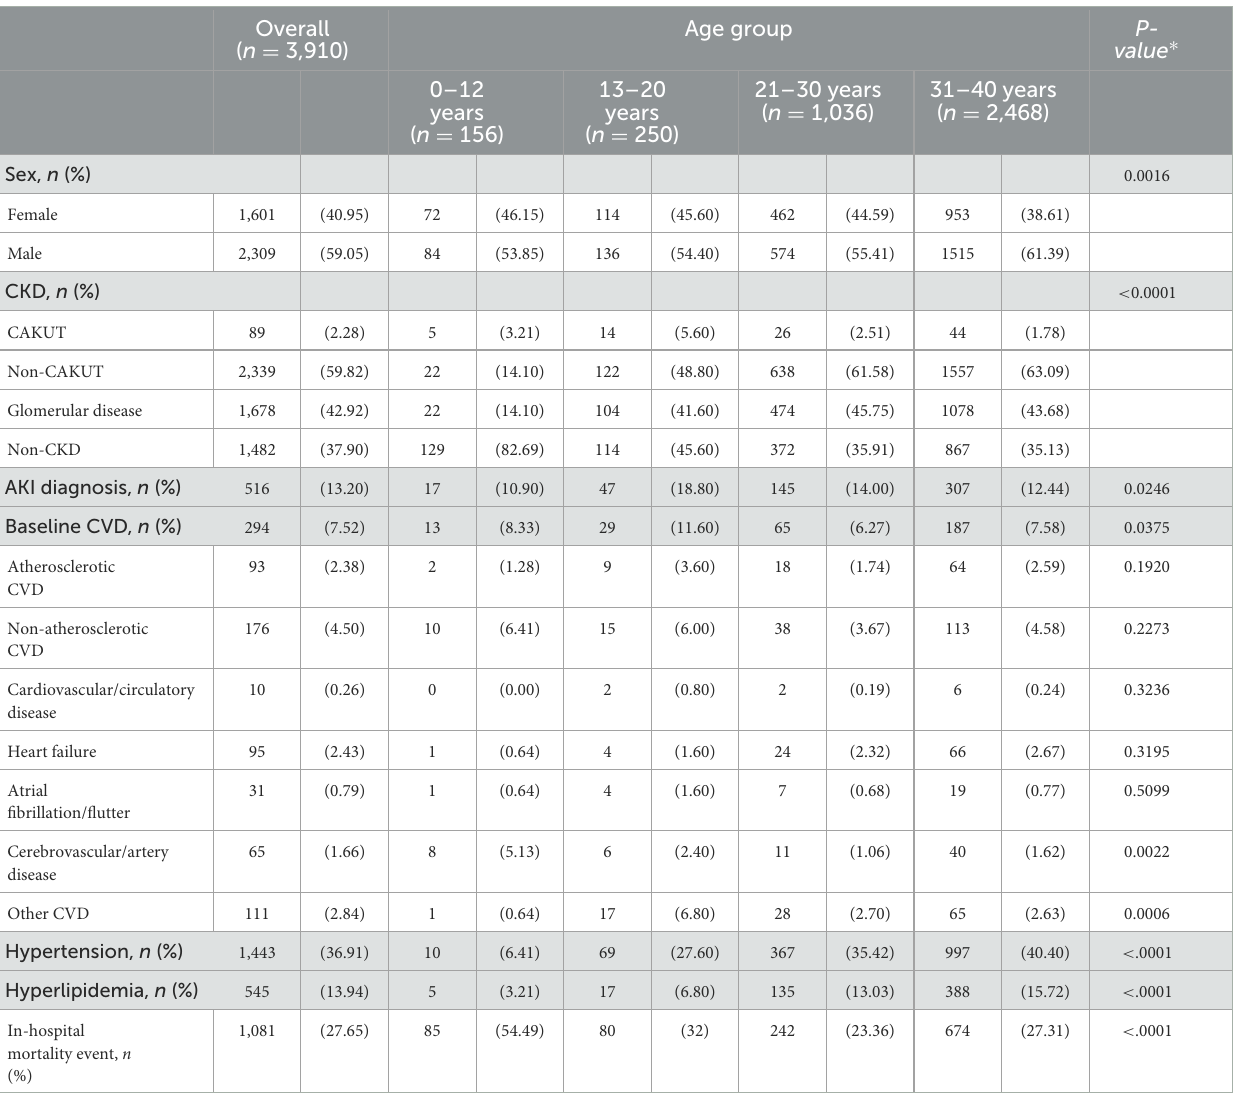
TABLE 1 Study cohort characteristics by age